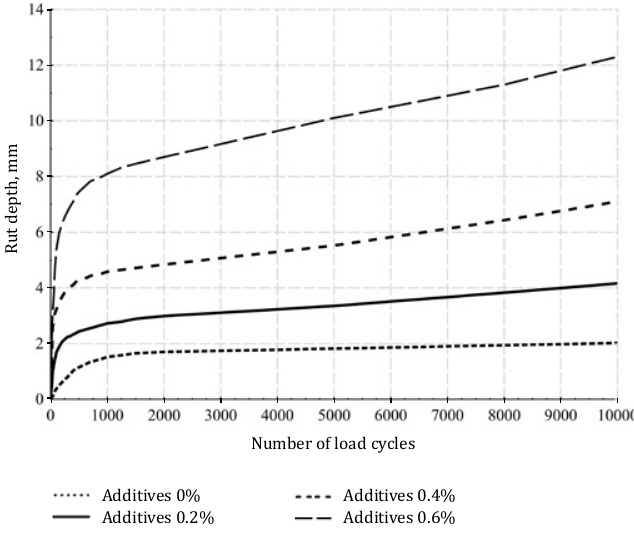
Figure 18. The effect of rejuvenator on the resistance to visco-plastic